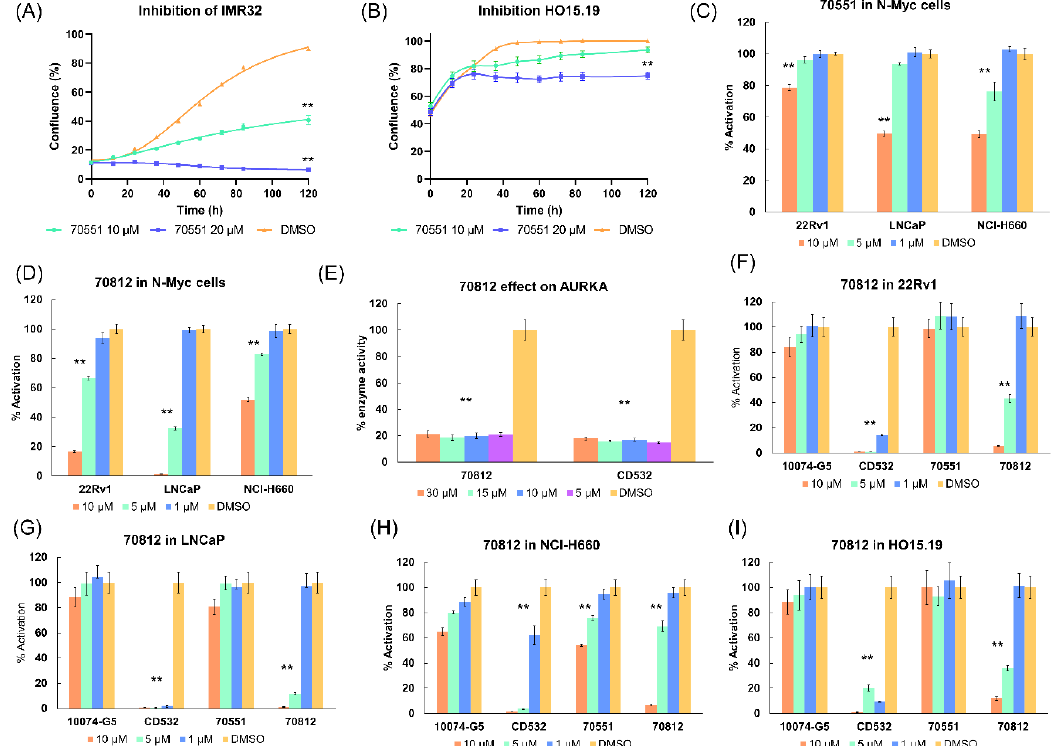
Figure 4. 70812’s inhibitory profile against N-Myc and AURKA. ( A ) Inhibitory activity of 70551 was first determined. IMR32 cells were treated with 70551 at 10 μM and 20 μM for 120 h, and the growth